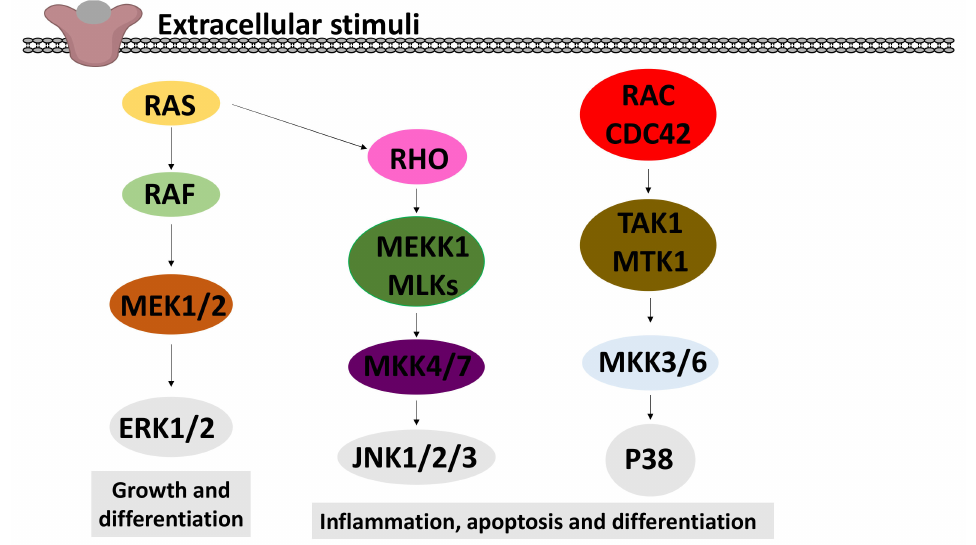
Figure 7. A schematic model of the MAPK signalling pathways. This model shows the three major pathways of MAPK: extracellular signal-regulated kinase (ERK) 1 and 2, c-Jun N-terminal kinases (JNK) 1–3 and p38 MAPK. In all these pathways, the activation of a small GTPase (RAS, RHO or RAC/CDC42) leads to the activation of a MAP kinase kinase kinase (MAPKKK: RAF, MEKK1/MLK, TAK/MTK1), which activates a MAP kinase kinase (MAPKK) by phosphorylation. These MAPKKs finally phosphorylate and activate the MAPKs (ERK1/2, JNK1/2/3 and